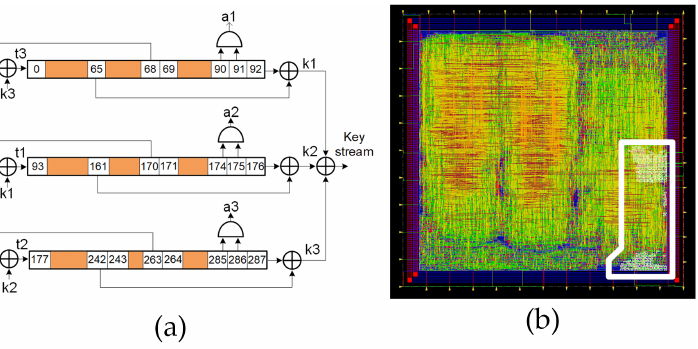
Figure 2. ( a ) Schematic representation of the standard Trivium stream cipher; ( b ) layout of the ASIC highlighting the location of the two standard